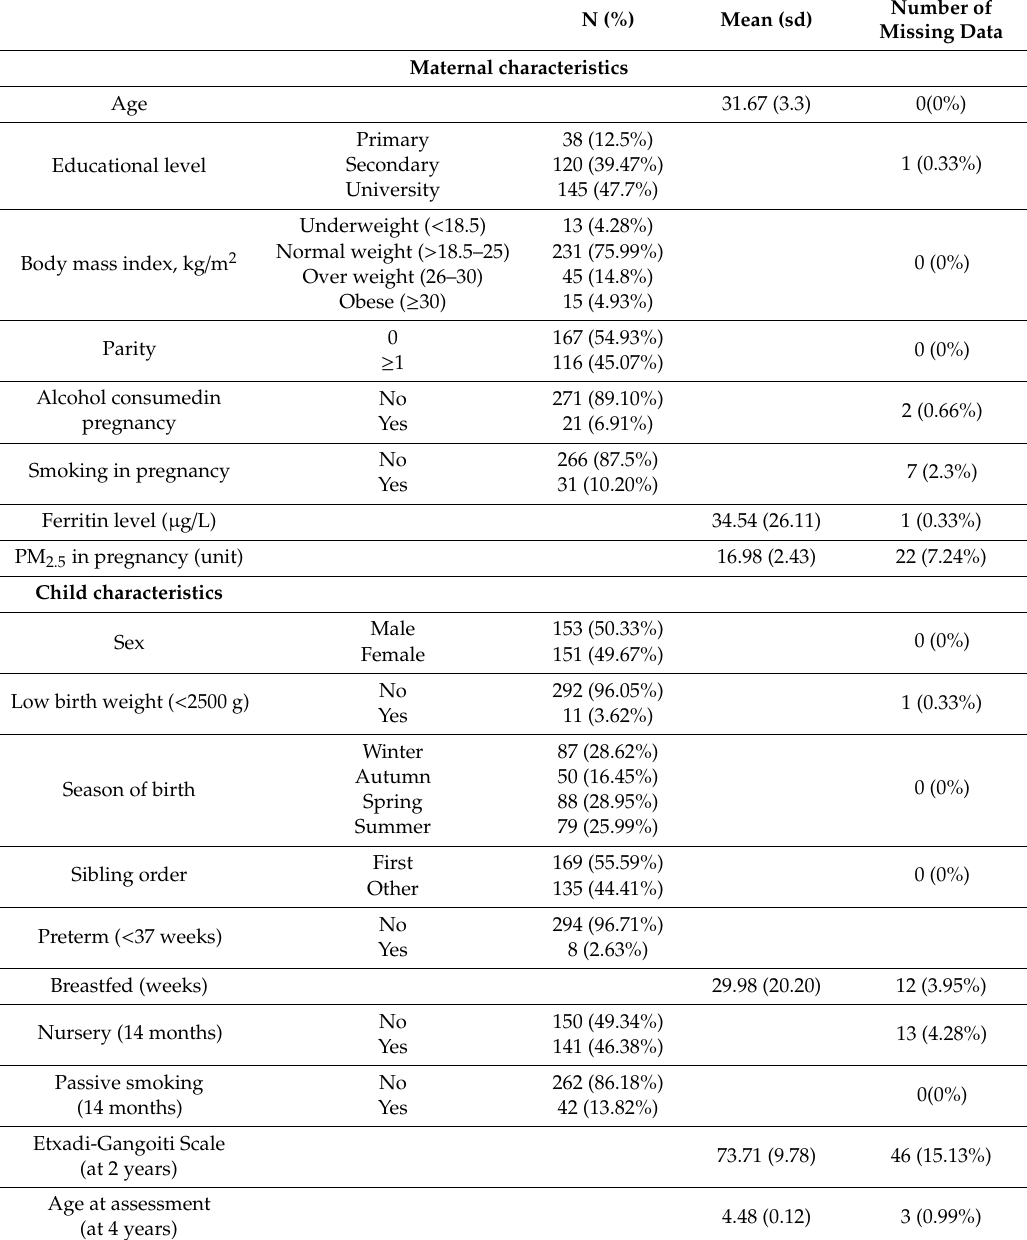
Table 1. Characteristics of the study